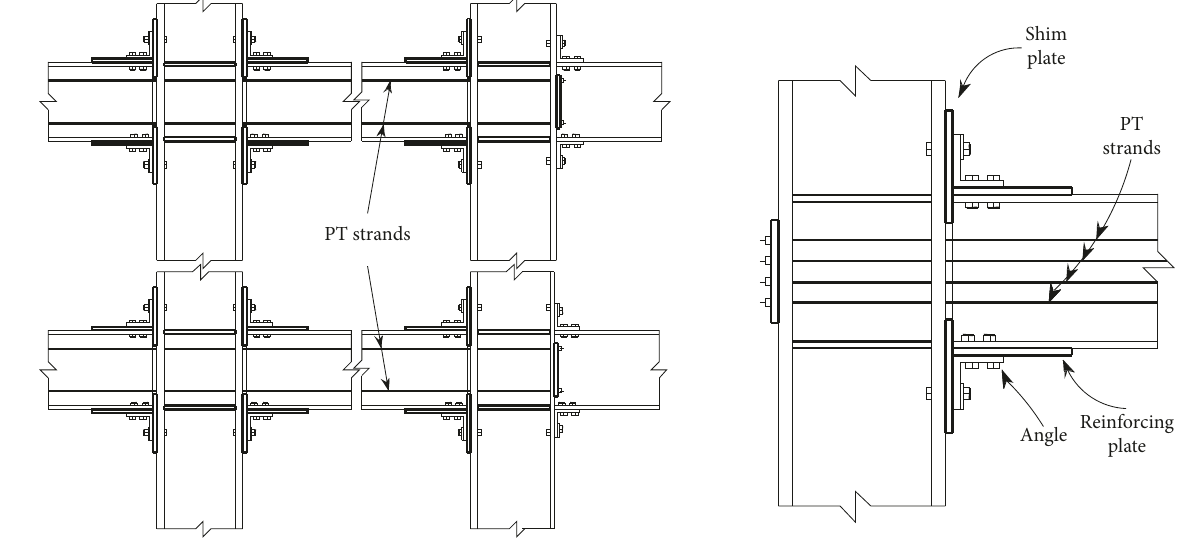
Figure 2: Angles and posttensioned strands in the FPTC structures.